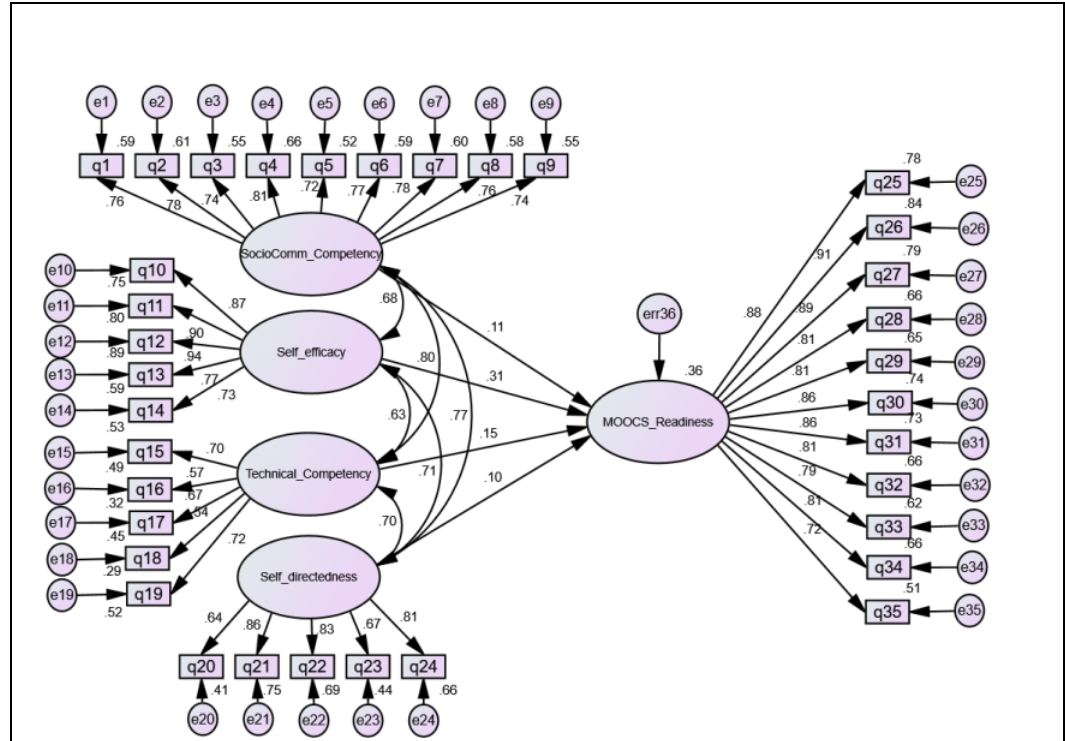
Figure 2. Schematic diagram of